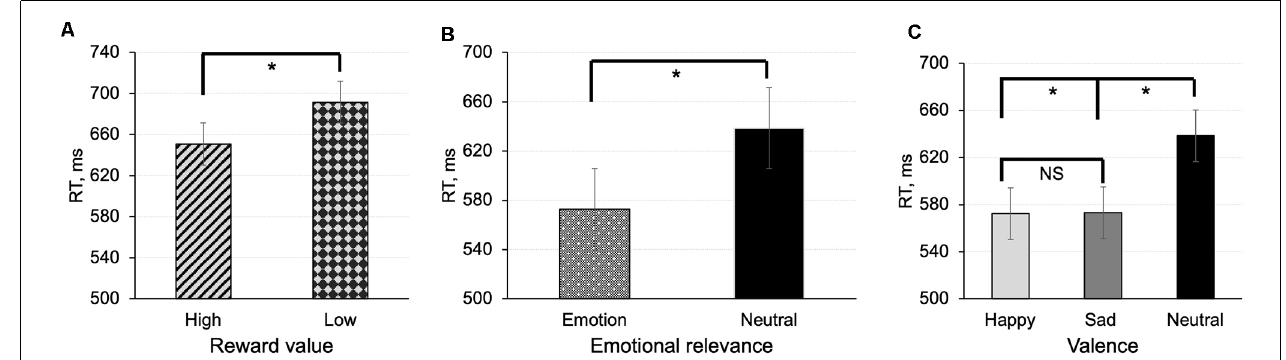
FIGURE 2 | Mean reaction time in the value-based task (A) and emotion task (B,C) for matched (correct pairings) associations between shapes and labels. In the emotion task, we calculated effects of emotional relevance (averaged effect of emotions) (B) , and emotional valence (C) . The error bars represent ± SEM. * p < 0.05; NS, non-significant.